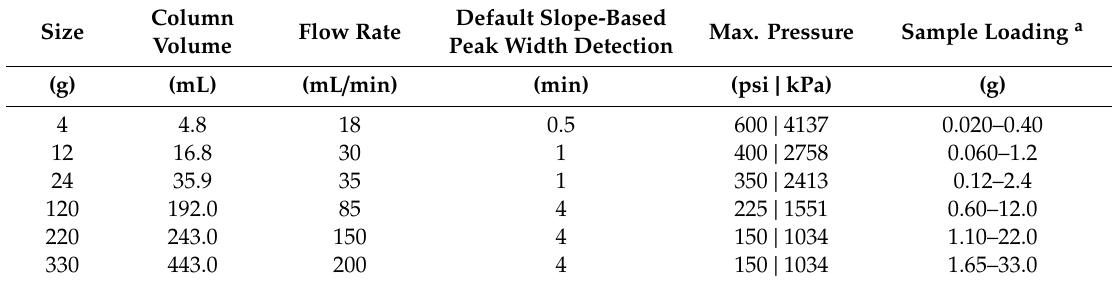
Table 1. Manufacturer’s (Teledyne-Isco) specifications and recommended parameters for the RediSep Rf Gold (High Performance) Silica Gel (20–40 microns) Disposable Flash Chromatography